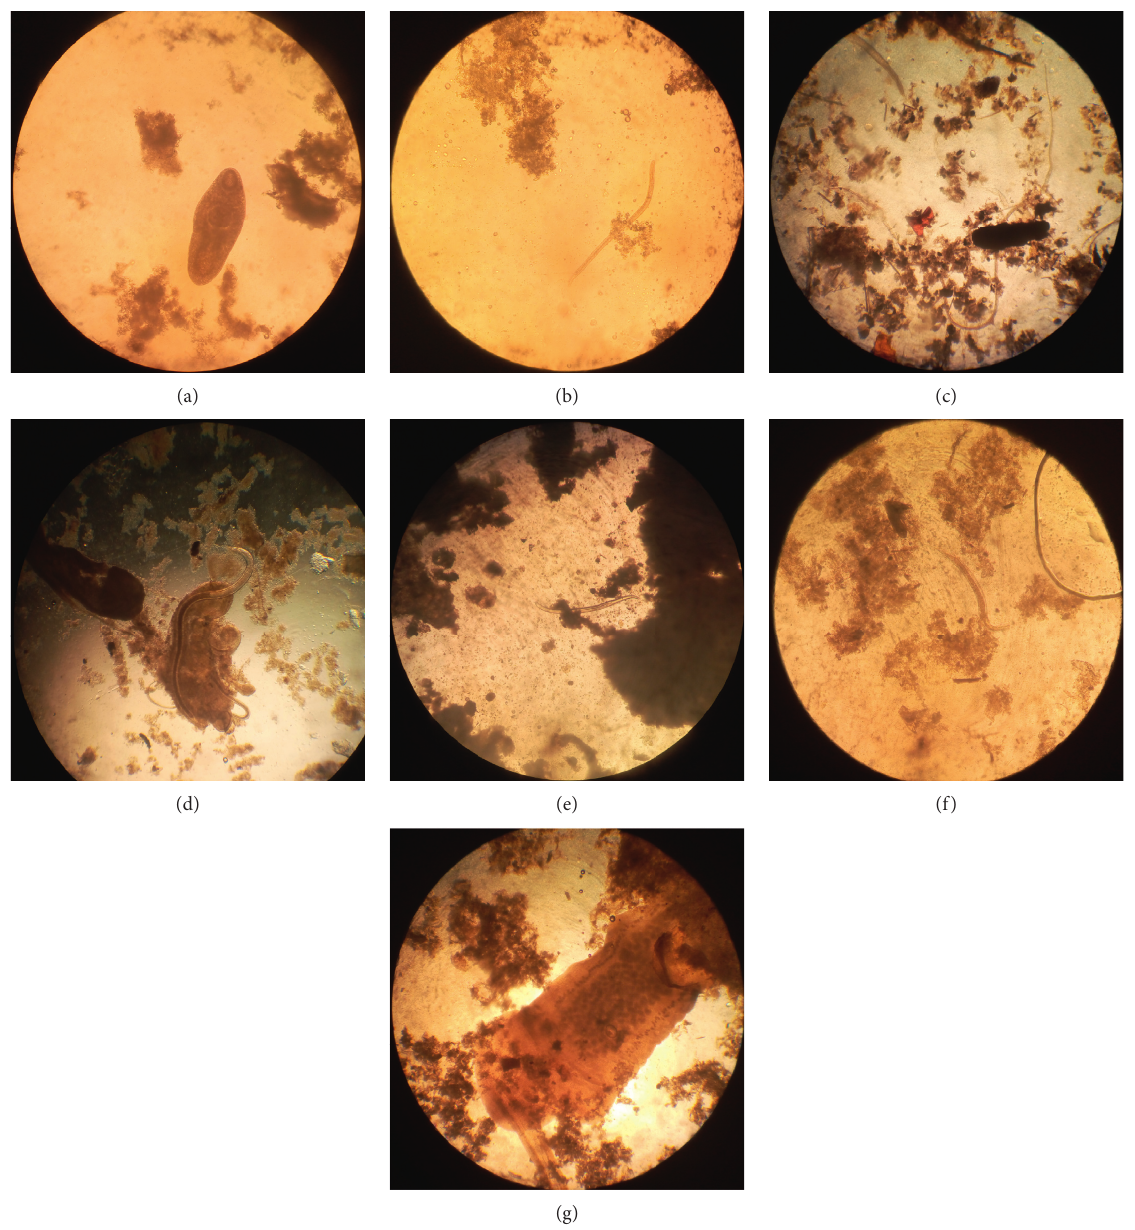
Figure 2: Parasites observed in fish species from rivers Niger and Benue. (a) Clinostomum sp. (Trematoda: Digenea), (b) Camallanus species (nematode), (c) Capillaria sp. (nematode), (d) Rhabdochona congolensis (nematode), (e) Spinitectus guntheri , (f) Contracaecum sp. (nematode), and (g) Proteocephalus sp. Table 1: Prevalence of parasites of fish species in rivers Niger and Benue at Lokoja. Fish